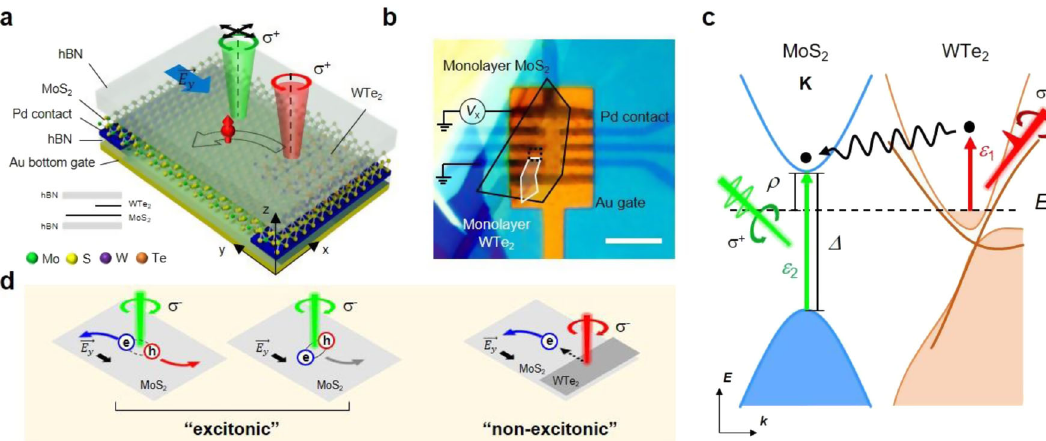
Fig. 1 Experimental schemes of non-excitonic valley Hall effect. a The schematic diagram of the heterobilayer device with Au bottom gate (dark yellow ! layer) and the remote optical measurements is shown (drawn by authors). Under the longitudinal electrical bias E y between Pd electrodes (dark blue), the spin-polarized electrons are selectively excited by the circularly polarized ( σ + in the fi gure) 50 fs 1.55 eV short pulse (red beam), and the VHE (black arrow) is observed by another laser (green beam). b An optical microscope image of the heterobilayer device is shown. The monolayer MoS 2 and WTe 2 are marked with the black and the white line, respectively. The dashed black line shows the spatial region where the 2D scanning experiments were performed. The longitudinal fi eld is applied by the bias voltage V x . The scale bar (white) is 10 μ m. c A schematic energy diagram of the MoS 2 (blue)/WTe 2 (orange) heterobilayer. The short-pulse light excitation with energy ε 1 (red) below the bandgap of MoS 2 ( Δ ) selectively excites the spin-polarized electrons (black dots) in WTe 2 . Another light excitation with energy ε 2 (green) is applied to observe the effect of the injected electrons. d The excitonic VHE involves both the unbound (left) and the bound (right) electron – hole pairs. The non-excitonic VHE is unipolar without exciton formation or dissociation. All measurements were performed at a liquid nitrogen temperature of 78 K.